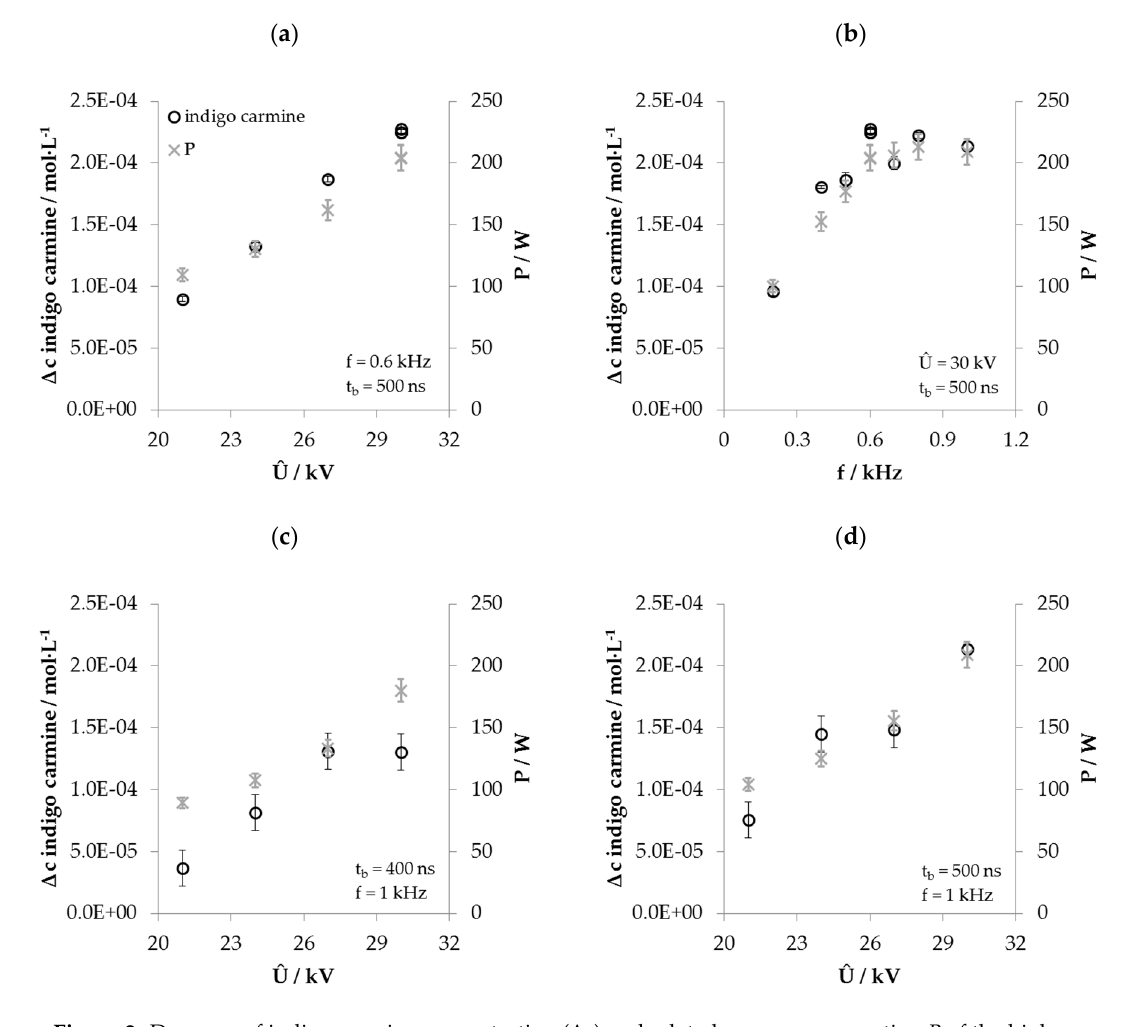
Figure 2. Decrease of indigo carmine concentration ( ∆ c ) and related power consumption P of the high voltage (HV) generator as a function of ( a ) voltage amplitude Û , ( b ) pulse repetition rate f , and ( c ) and ( d ) pulse duration t b .